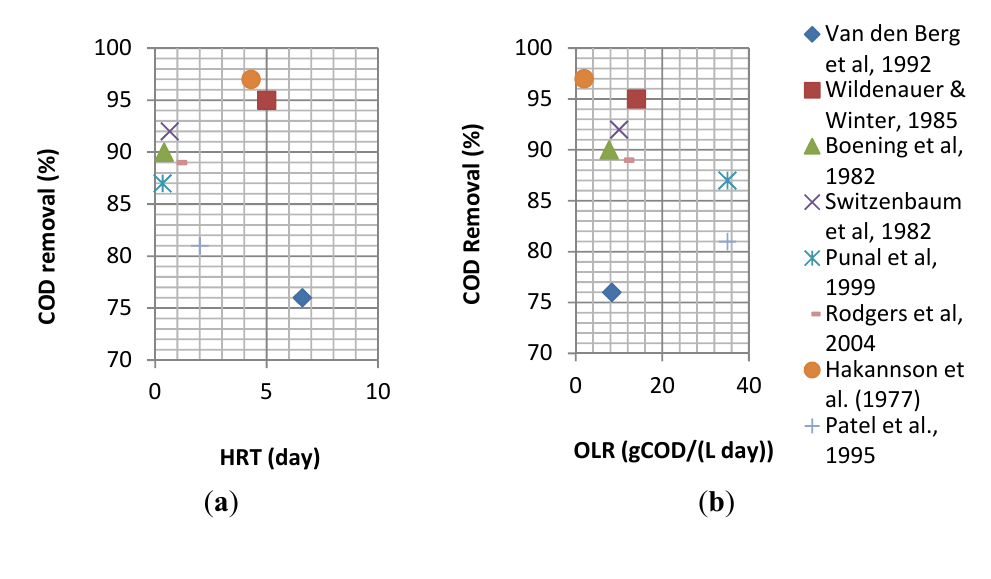
Figure 3. Maximum COD removal versus ( a ) HRT (day) and ( b ) OLR [g COD/(L day)] using anaerobic filters, fluidized bed reactors and fixed film reactors for CW